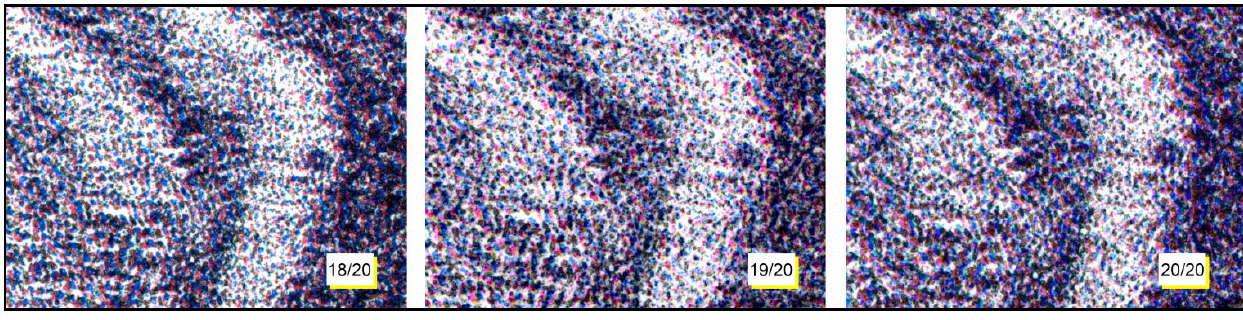
Figure 12. Lithograph particular captured from three different copies of the same